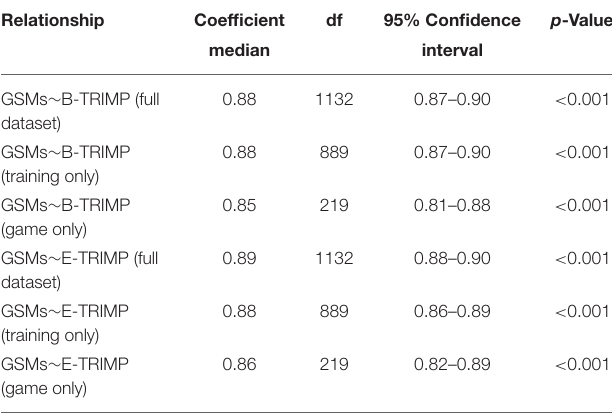
TABLE 1 | Repeated measures correlations between GSMs, B-TRIMP, and E-TRIMP. Relationship